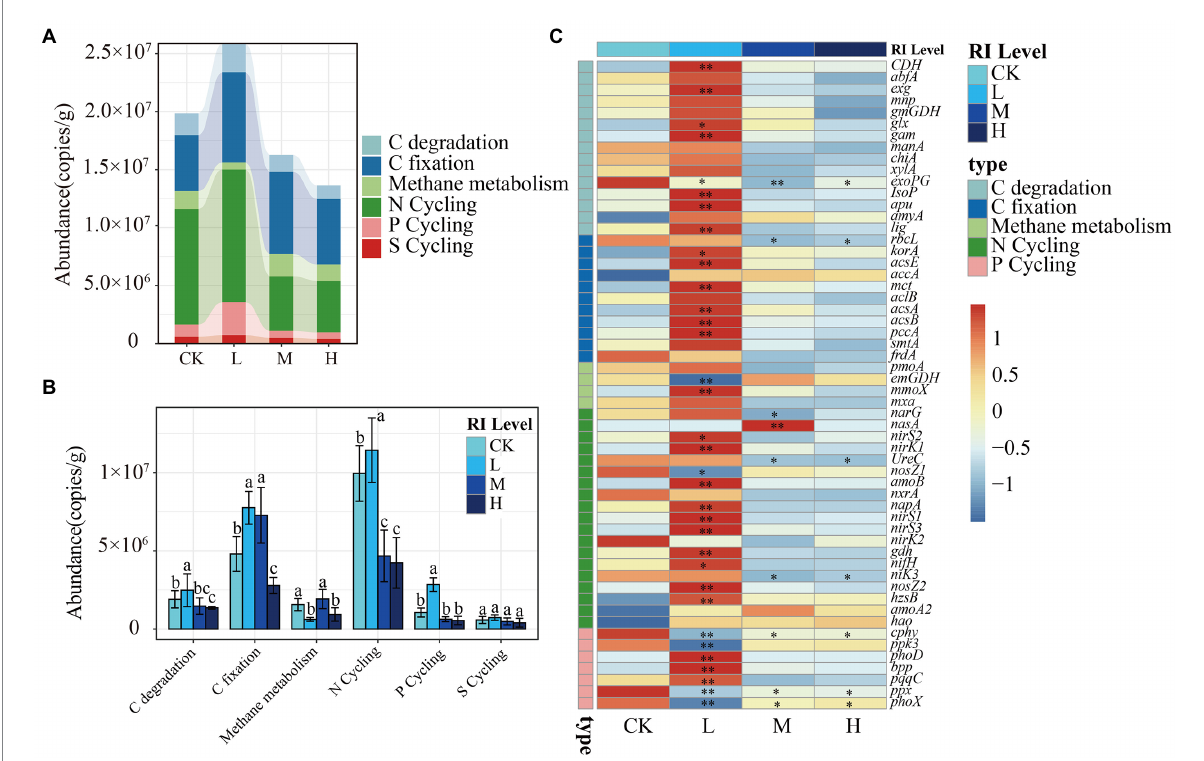
FIGURE 5 Functional genes. (A) The difference in abundance of functional genes under different RI levels. (B) The abundance of functional genes in the C, N, P, and S cycle. (C) The abundance of individual functional genes. Different lowercase letters indicate significant differences among different RI levels ( p < 0.05). The asterisk indicates a significant change in the corresponding genes in this treatment when compared with CK (* p < 0.05; ** p <